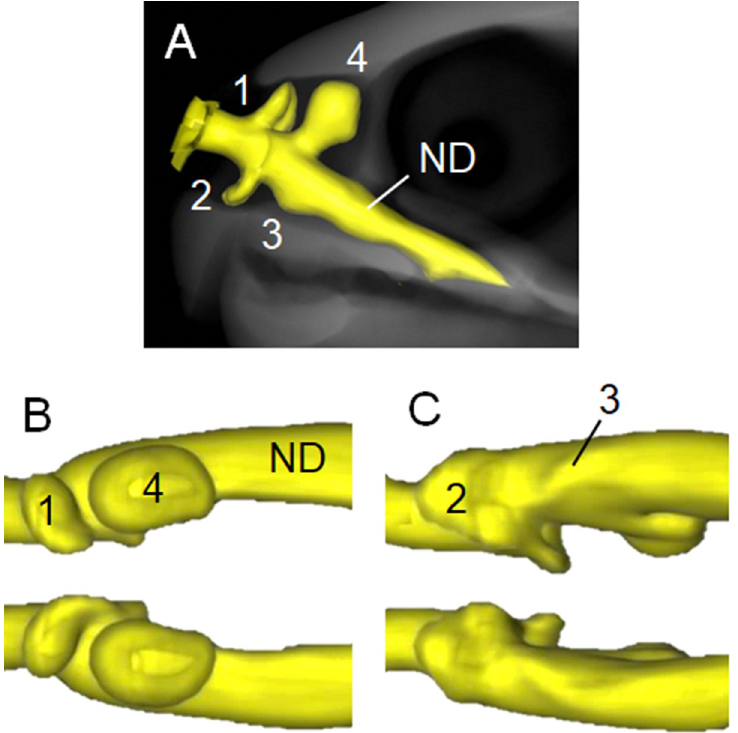
Fig 4. Three-dimensional reconstructions based on computed tomography images of nasal cavity of black sea turtle. (A) Left lateral view of nasal cavity structure (yellow) at anterior region of skull. Dorsal (B) and ventral (C) views of nasal cavity. Anterodorsal (1), posterodorsal (4) and anteroventral (2) diverticula, and small posteroventral salience formed by fossa on wall (3) in cavum nasi proprium anterior to nasopharyngeal duct (ND). Cheloniidae, namely the green ( C . mydas ) and loggerhead ( C . caretta ) sea turtles [10,13]. The cavum nasi proprium of all three of these species comprised anterodorsal, posterodorsal and anteroventral diverticula, and a small posteroventral salience formed by a fossa on the wall, and the relative size of the olfactory region to the cavum nasi proprium was also similar among sea turtle species. Water easily enters the anterodorsal and anteroventral diverticula and the posteroventral fossa on the wall, but hardly enters the posterodorsal diverticulum in the nasal cavity of green sea turtles [10]. In addition, the anterodorsal—anteroventral divertic- ula, the posteroventral fossa, and the posterodorsal diverticulum within the nasal cavity of green sea turtles are each covered by different types of sensory epithelium [10]. Therefore, the anterodorsal and anteroventral diverticula and the posteroventral fossa appear to receive water-soluble odorants, whereas the posterodorsal diverticulum likely detects volatile odorants [14]. The nasal cavities of hawksbill, olive ridley and black sea turtles are structurally similar; thus the distribution of water and air is likely to be similar in the nasal cavities between these species and green sea turtles. On the other hand, the architectural features of the nasal cavity of the dermochelyid leatherback sea turtle ( D . coriacea ) (Fig 1; S3 Video) differ considerably from those of Cheloniidae [13]. Although leatherback sea turtles also have two diverticula and two fossae on the wall, they are all located on the dorsal side of the nasal cavity [13]. In addi- tion, volume of the cavum nasi proprium in leatherback sea turtles is much larger than that in Cheloniidae species. In the future, histological analyses of the nasal cavity are required to guess the olfactory function in leatherback sea turtles.